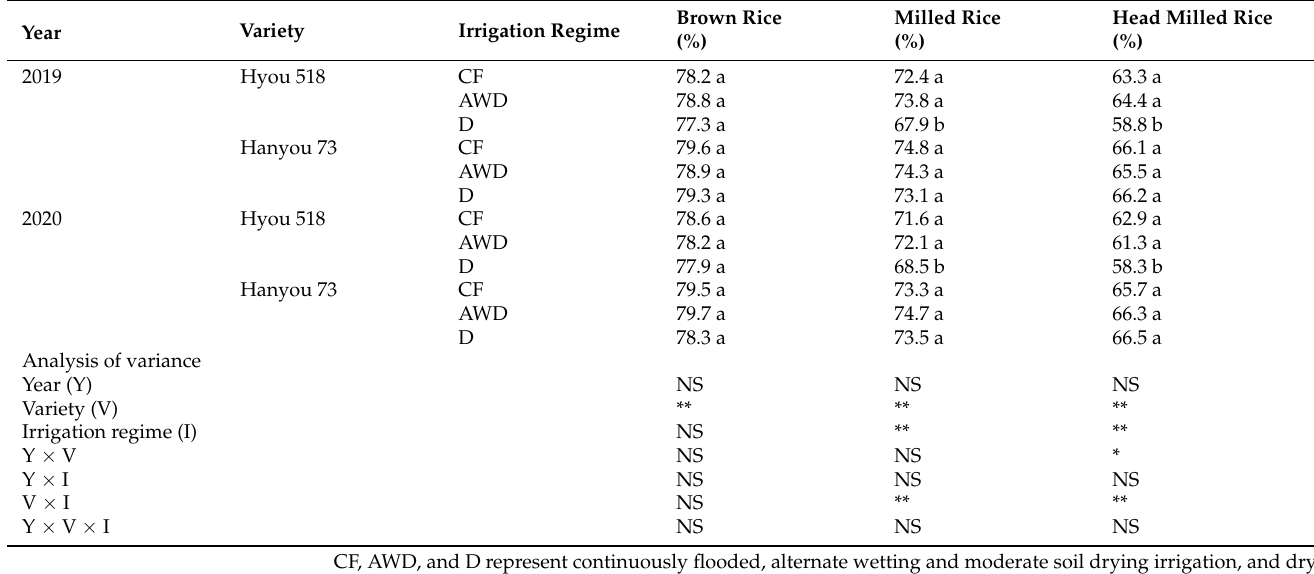
Table 1. Milling quality under various irrigation treatments.